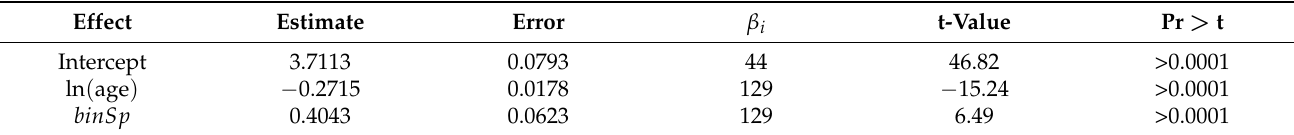
Table 4. Estimates for model parameters.